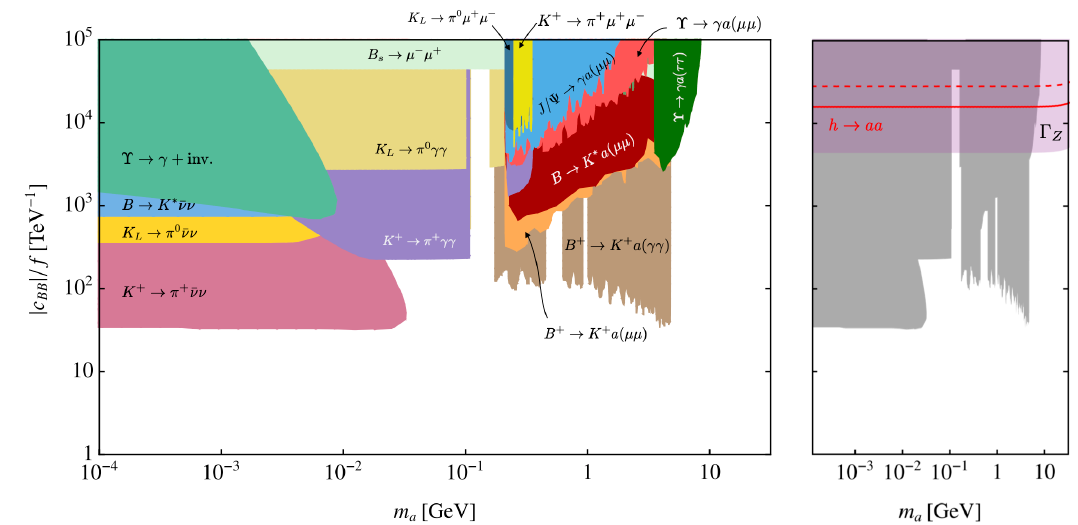
Figure 21 . Left: flavor bounds on ALP couplings to the hypercharge gauge boson, with all other Wilson coefficients set to zero at Λ = 4 πf and f = 1 TeV. Right: comparison of the same flavor constraints (light gray) with the constraints on Z → aγ decays from the LEP measurement of the Z boson width (violet) and contours of constant Br ( h → aa ) = 10 − 1 and 10 − 2 as depicted in red dotted, dashed and solid